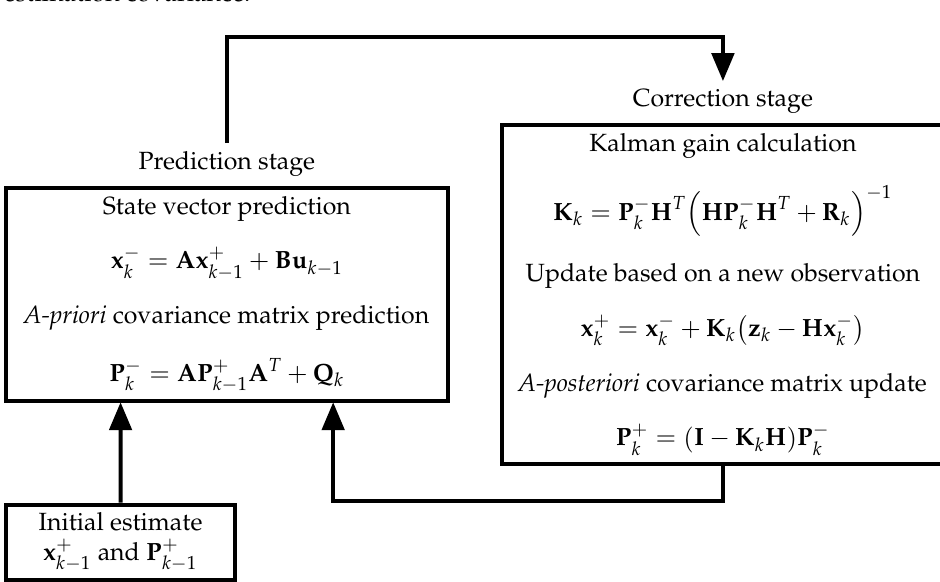
Figure A1. Kalman filter